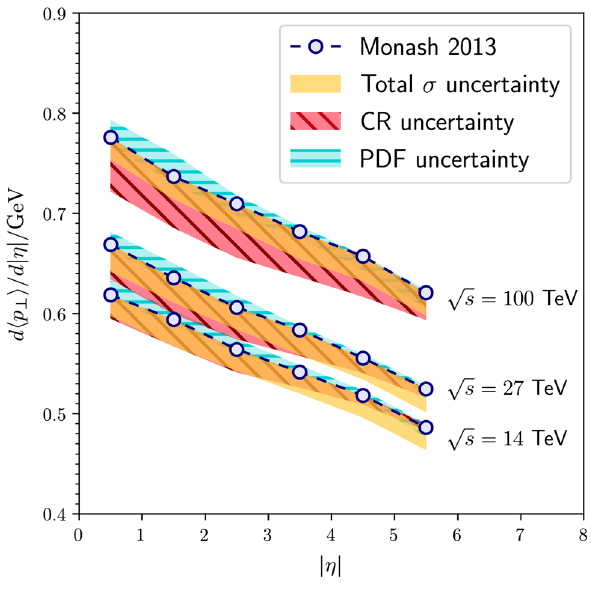
Fig. 7 Differential average transverse momentum of charged tracks as a function of pseudorapidity